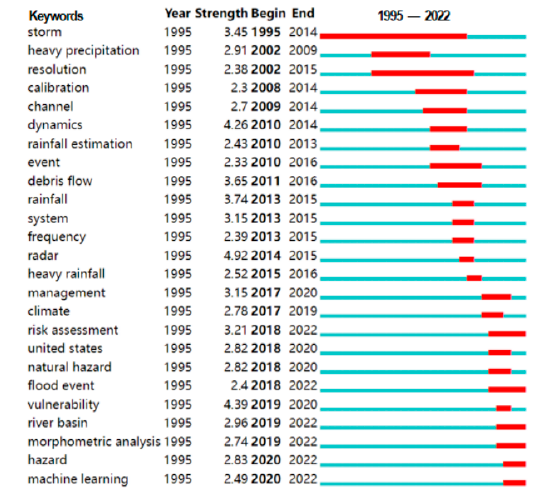
Figure 10. Keyword mutation